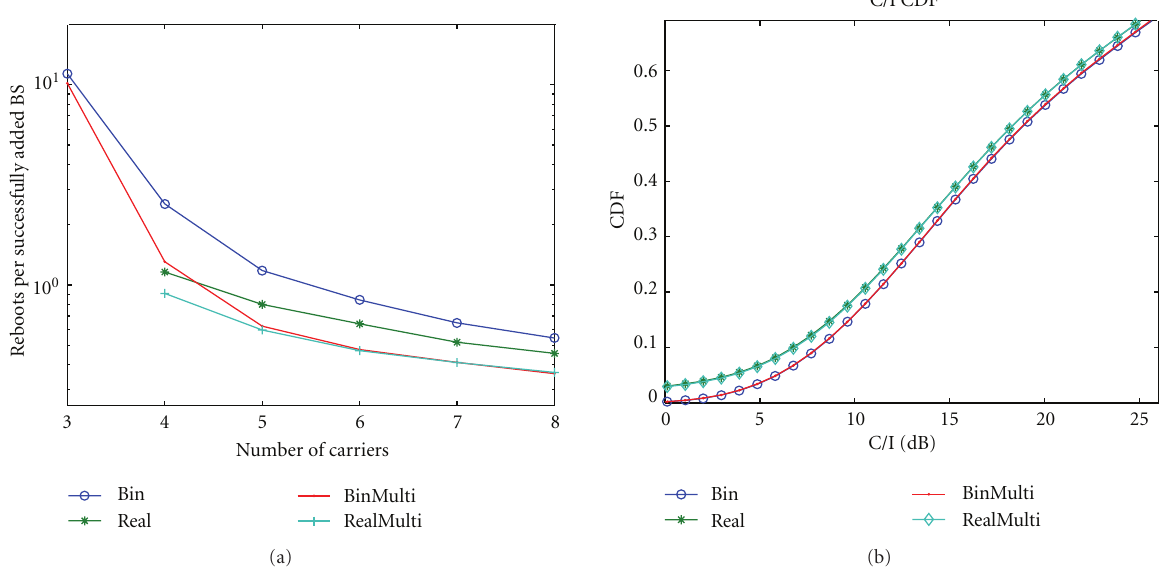
Figure 4: Performance of Primary Component Carrier Selection algorithms. (a) Number of cell reboots versus number of PCIs (only converged drops considered). (b) C/I CDFs for five component